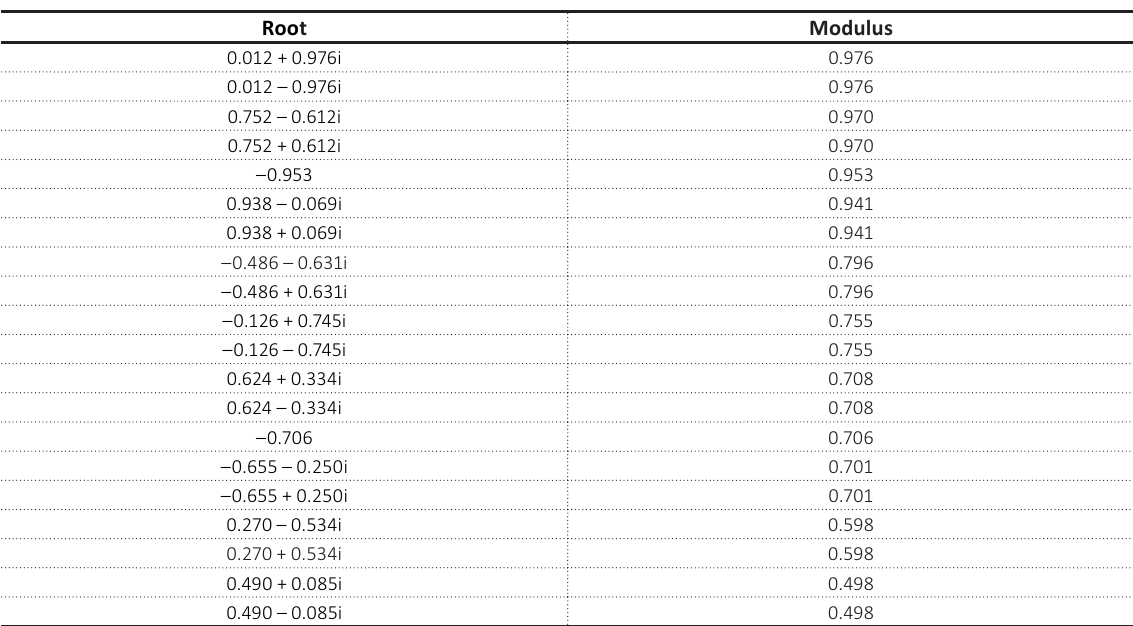
Table A3. Polynomial test result